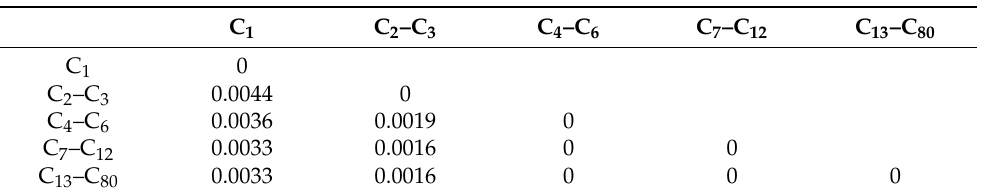
Table 2. Binary interaction coefficient of studied fluid [34].